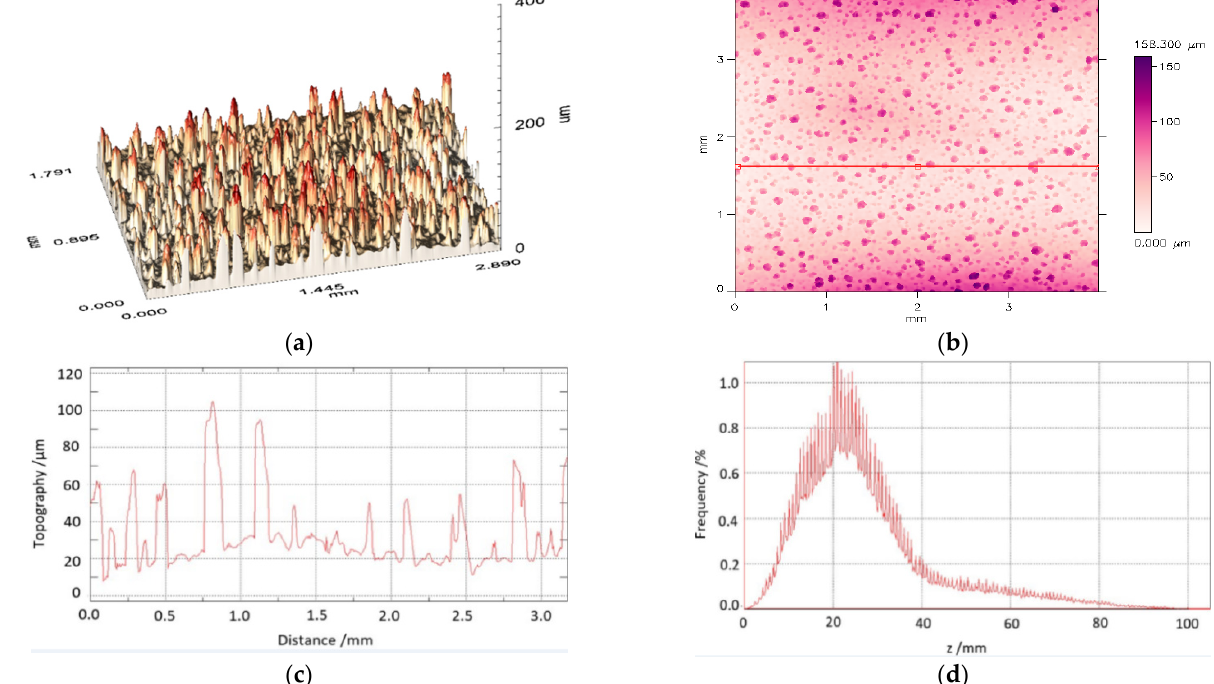
Figure 2. Results of the TSP coating surface morphology investigation: ( a ) Three-dimensional surface image; ( b ) two-dimensional surface mapping; ( c ) typical profile (Figure 2b, red line cross-section); ( d ) diagram of a normalized dimensional spectral analysis result. Table 1. Transitions selected for thermometry.